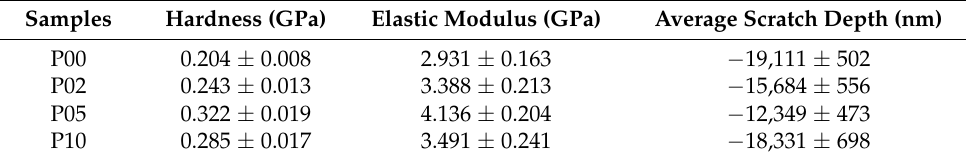
Table 2. The characterization of the hardness, elastic modulus, and average scratch depth of samples.